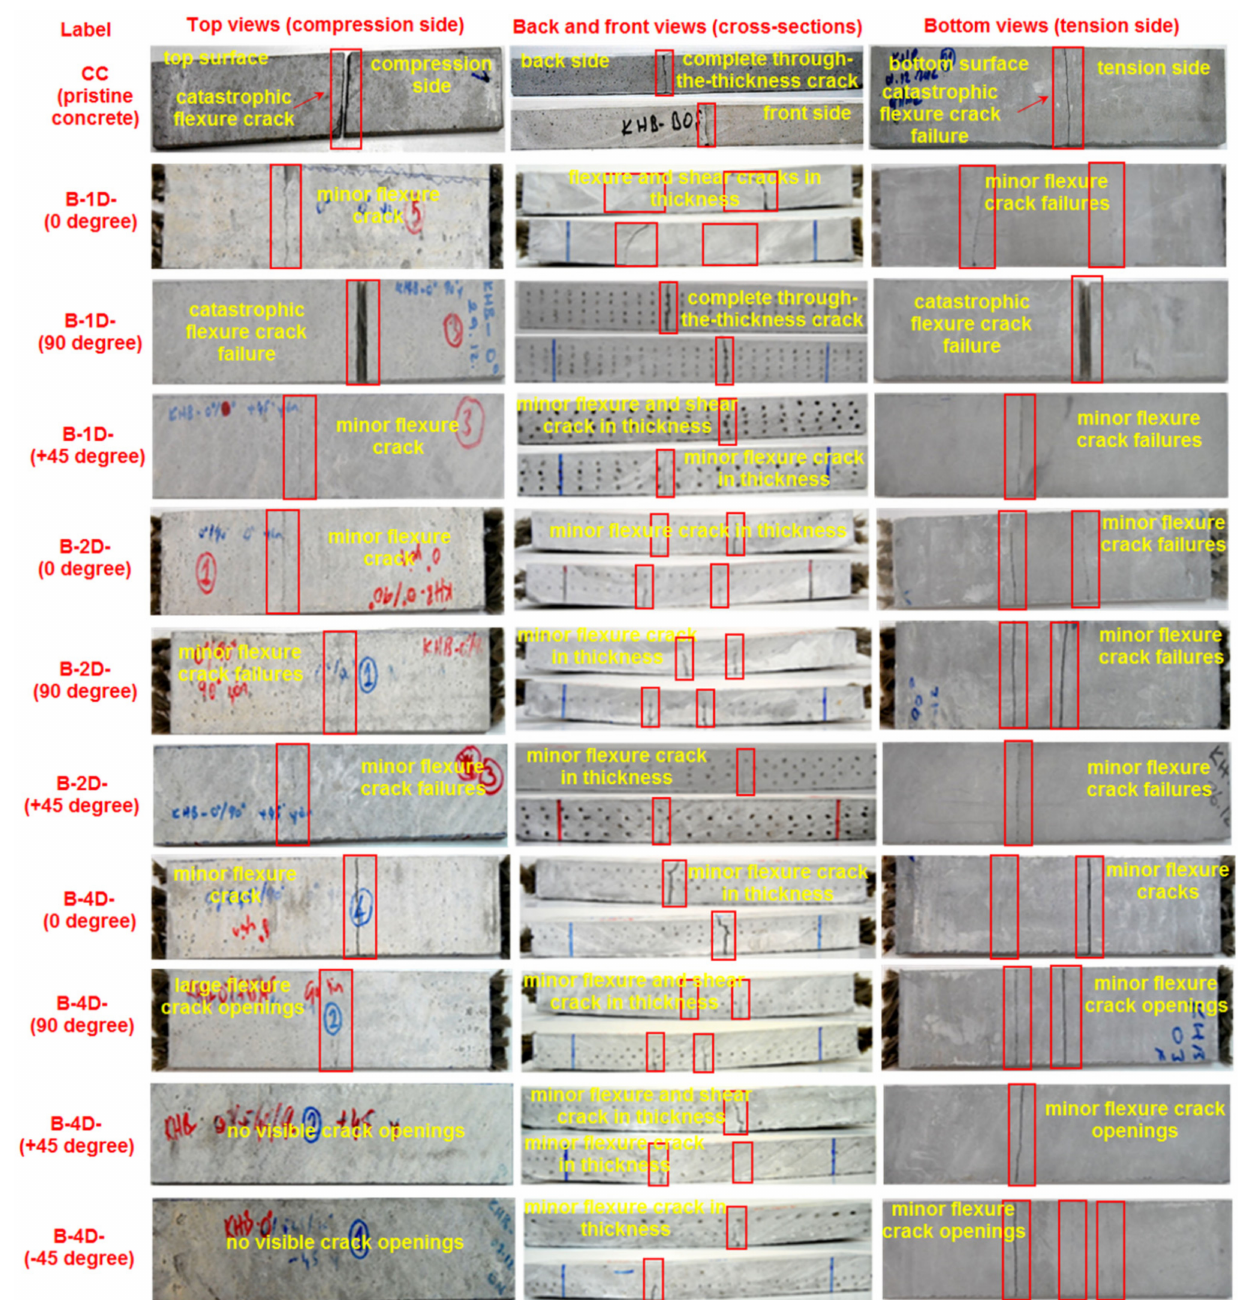
Figure 19. Various fractured multiaxis 3D basalt fibers including neat concretes top, bottom, cross-sections, and their failure modes after the off-axis flexure test (digital photo